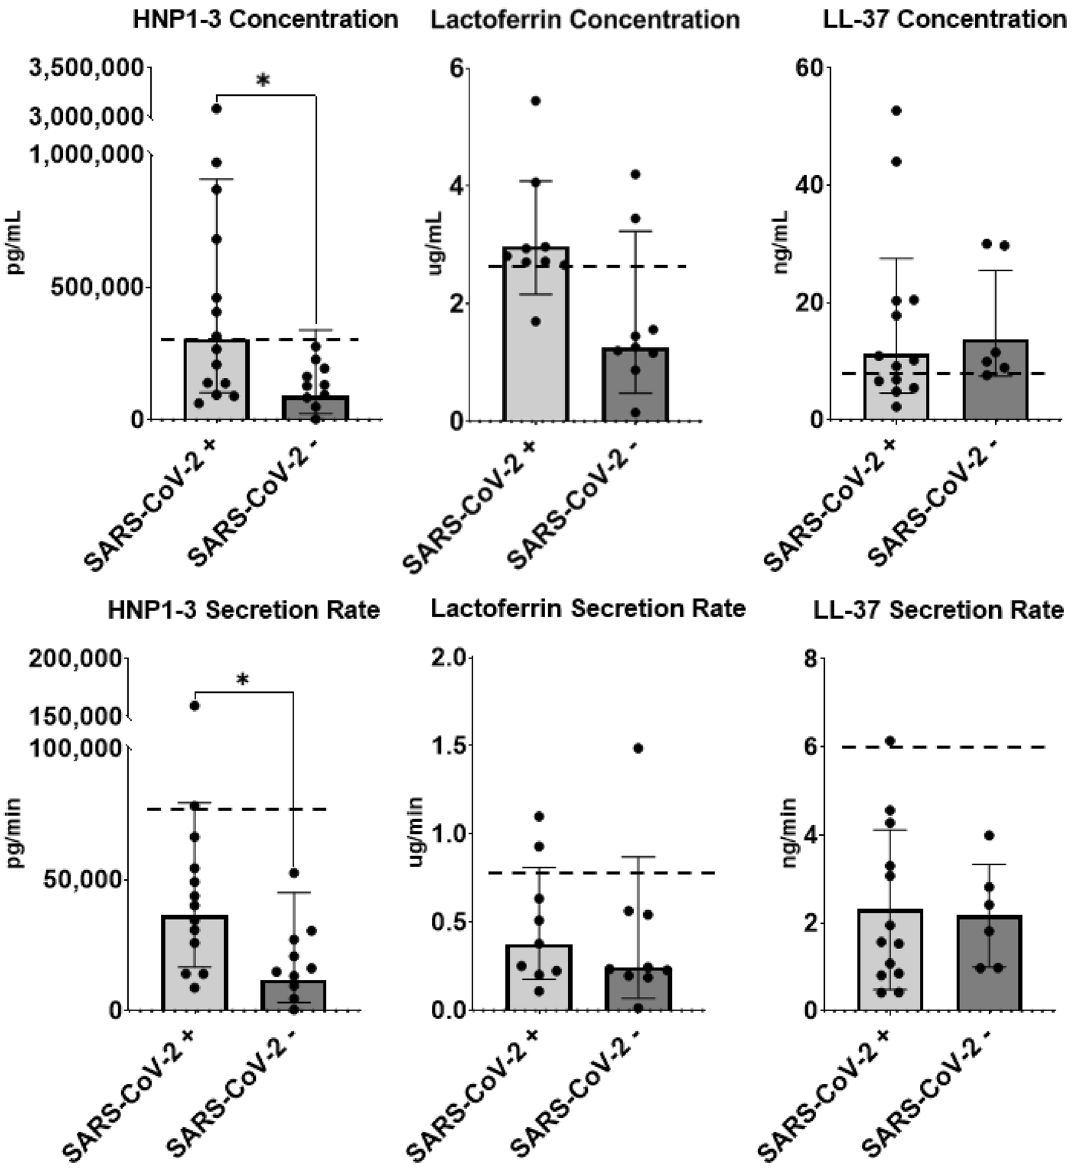
Figure 2. Concentrations and secretion rate of biomarkers of salivary immunity in athletes who had been infected with SARS-CoV-2 and those who had remained infection-free. Human neutrophil defensins (HNP1- 3), and dash line (–) represents normal values in elite athletes. * p < 0.005. Concentrations and secretion rates for LL-37 (n SARS-CoV-2 + = 13 ; n SARS-CoV-2- = 6) are presented as means ± S.D while HNP1-3 (n SARS- CoV-2 + = 14; n SARS-CoV-2- = 10) and Lactoferrin (n SARS-CoV-2 + = 9; n SARS-CoV-2- = 9) are presented as geometric means ±